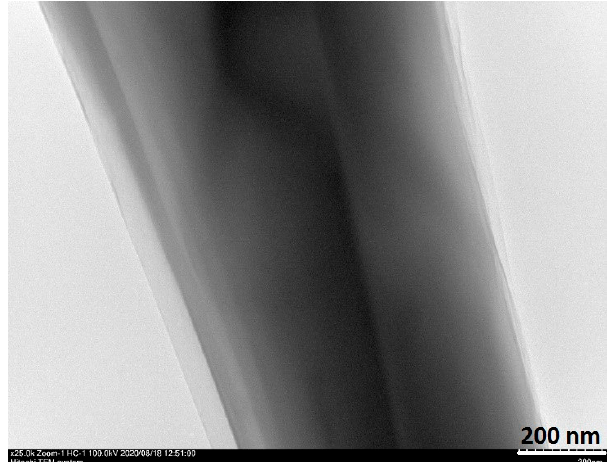
Figure 8. TEM sample prepared using the “nanofishing” procedure: Pd (OAc) 2 and 6b in acetonitrile.